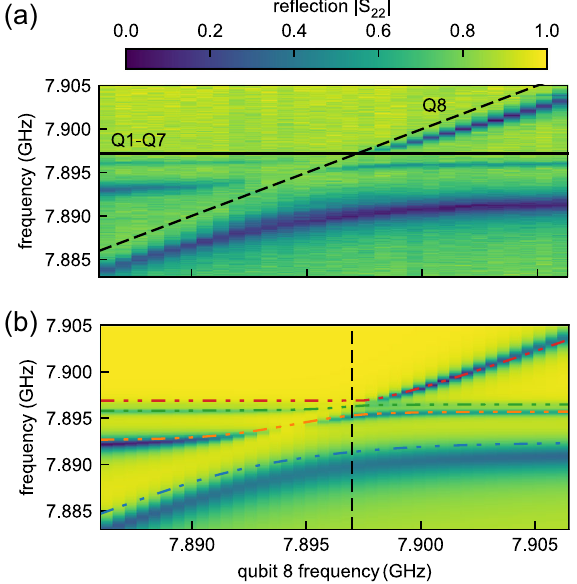
Fig. 3 Off-resonant qubits. a Measured absolute re fl ection ∣ S 22 ∣ for N = 7 resonant qubits at ω r /2 π = 7.897 GHz (solid black line) and qubit 8 being tuned through the collective resonance (black dashed line). b Calculated re fl ection with transfer matrix method and relevant eigenfrequencies of H eff (dash dotted lines) show good agreement with experimental result in ( a ). The vertical line indicates the resonance with ω 8 = ω r , corresponding to the situation observed in Fig.